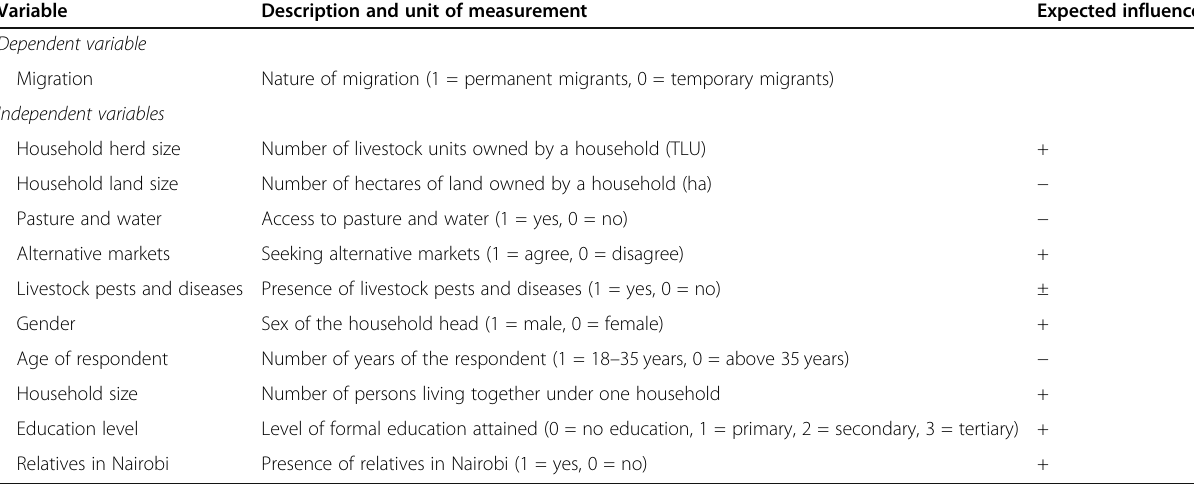
Table 1 Description of variables and expected influence